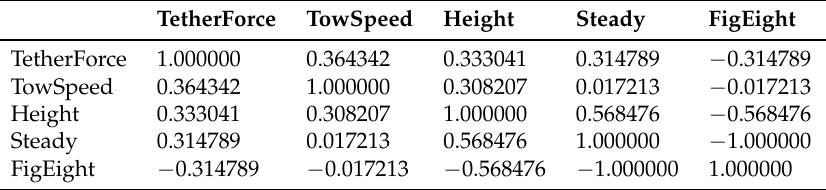
Figure 19. Absolute value of Pearson correlation coefficient (PCC) between input features and the output prediction (tether force). Table 3. Pearson correlation among the top-correlated features with the tether force.